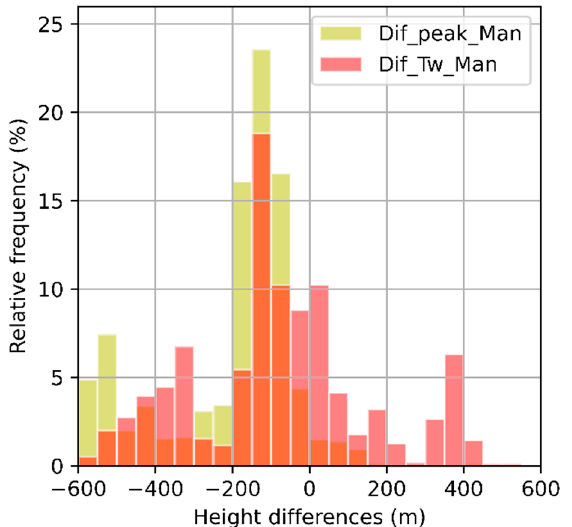
Figure 14. As in Figure 13b but for the manufacturer’s ML product.